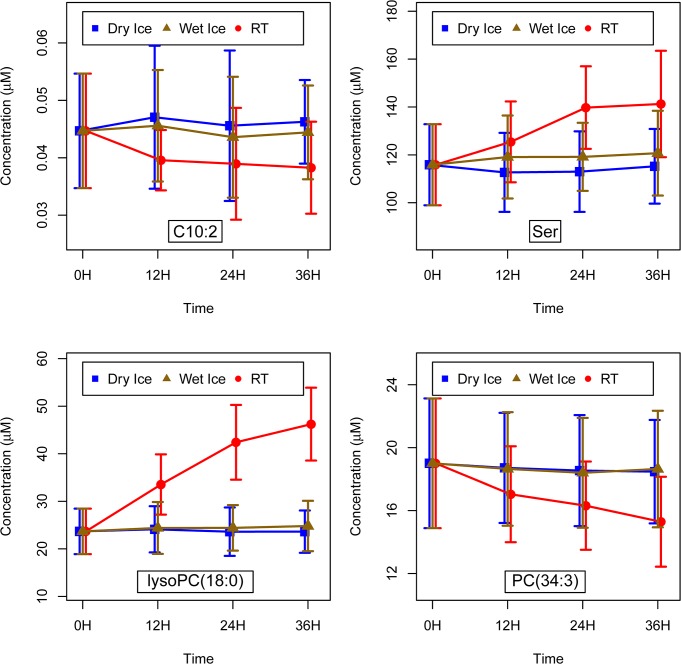
Examples of metabolite concentration changes associated to prolonged exposure of samples to room temperature in three metabolite groups.The displayed concentration values represent the mean of the samples of all 19 participants for the respective pre-analytical condition. The error bars represent one standard deviation based on the 19 measurements. Concentrations of the acylcarnitine decadienylcarnitine (C10:2), the amino acid serine (Ser), the glycerophospholipids lysophosphatidylcholine lysoPC(18:0) and diacylphosphatidylcholine PC(34:3) changed due to different pre-storage handling conditions of samples.